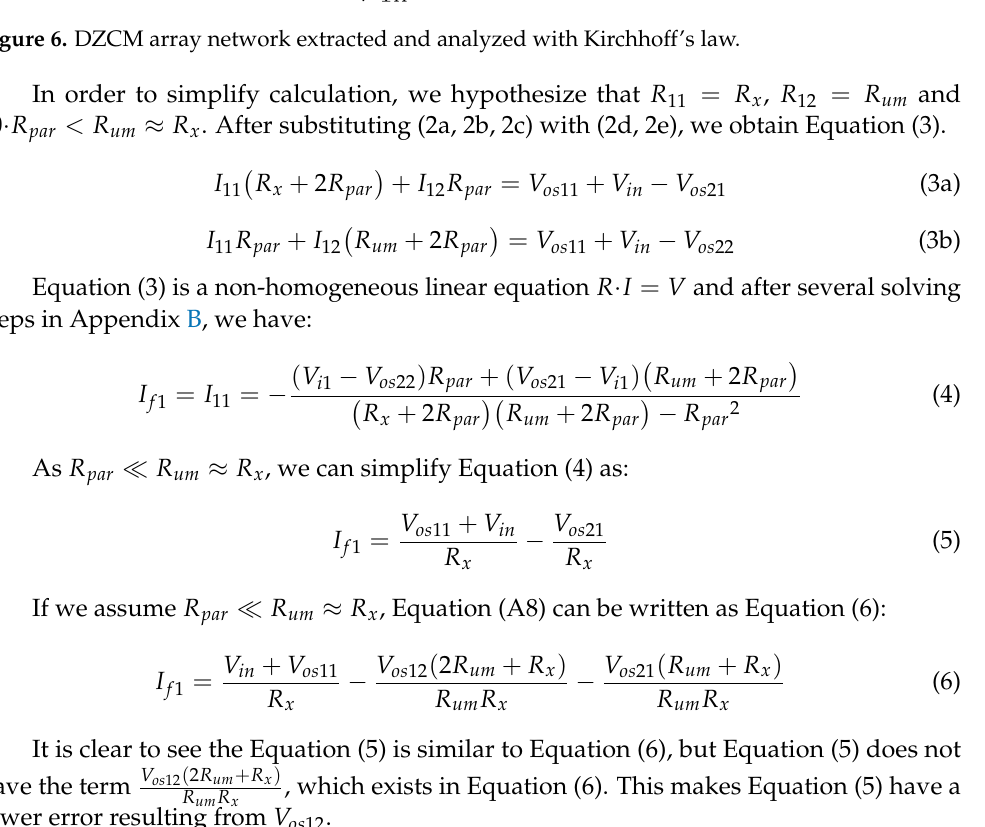
Figure 6. DZCM array network extracted and analyzed with Kirchhoff’s law.